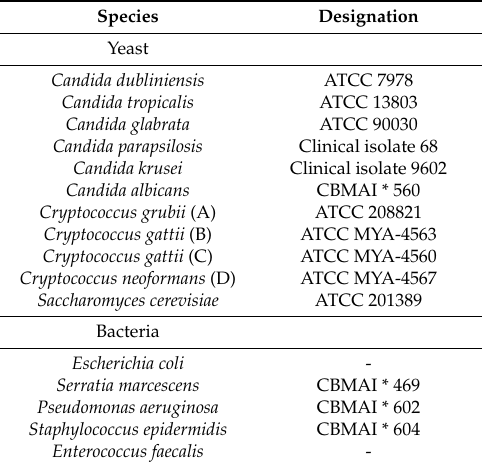
Table 1. Target strains used for antimicrobial activity